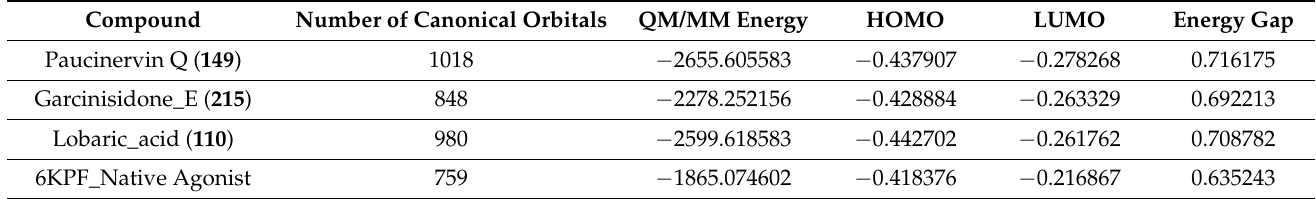
Table 2. HOMO, LUMO, energy gap, and QM/MM energies (kcal/mol).